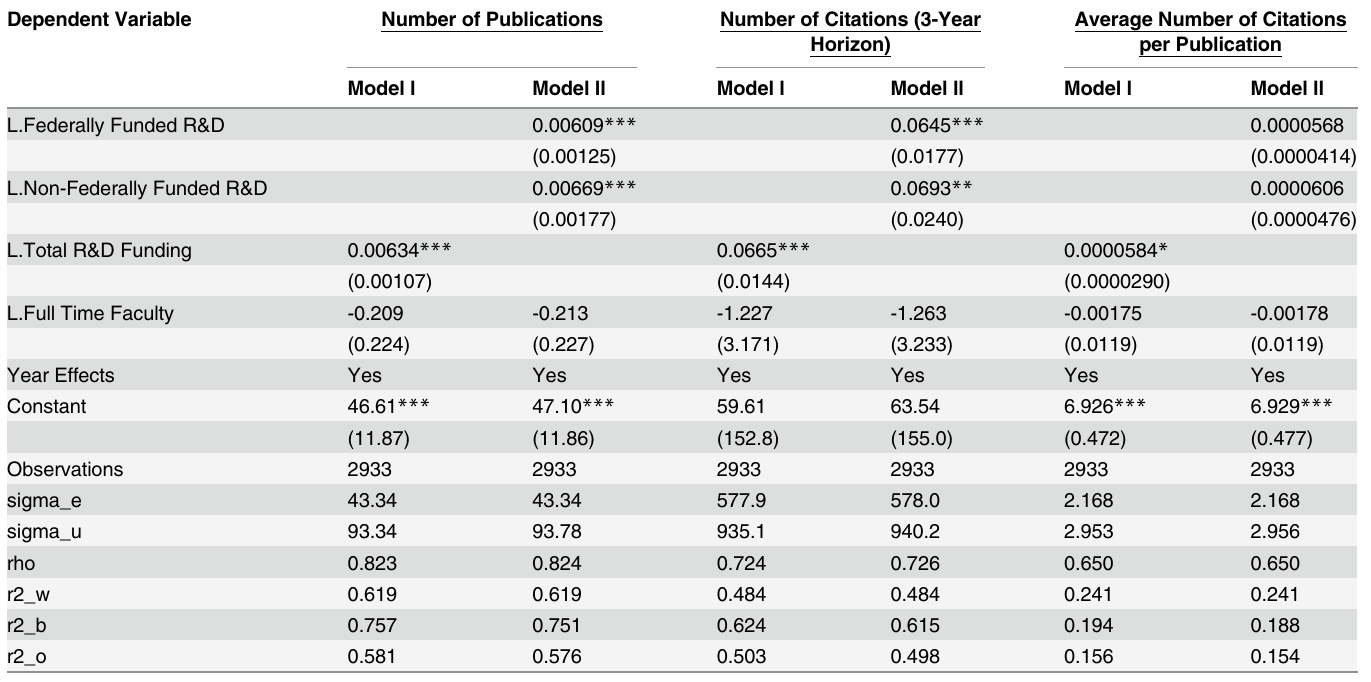
Table 2. OLS Panel Regressions Determinants of Publications, Citations, and Average Number of Citations per